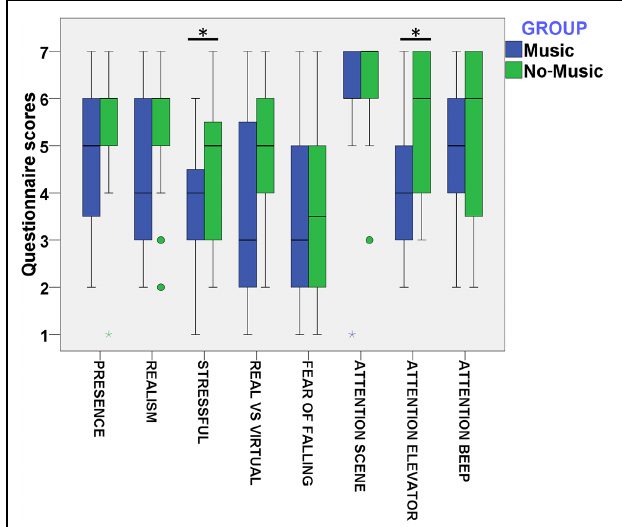
FIGURE 2 | Boxplot of VR related questions (Table 3) for the variables presence , realism , stressful , real vs virtual , fear of falling, and attention paid to the scene , sound of the elevator and the beep